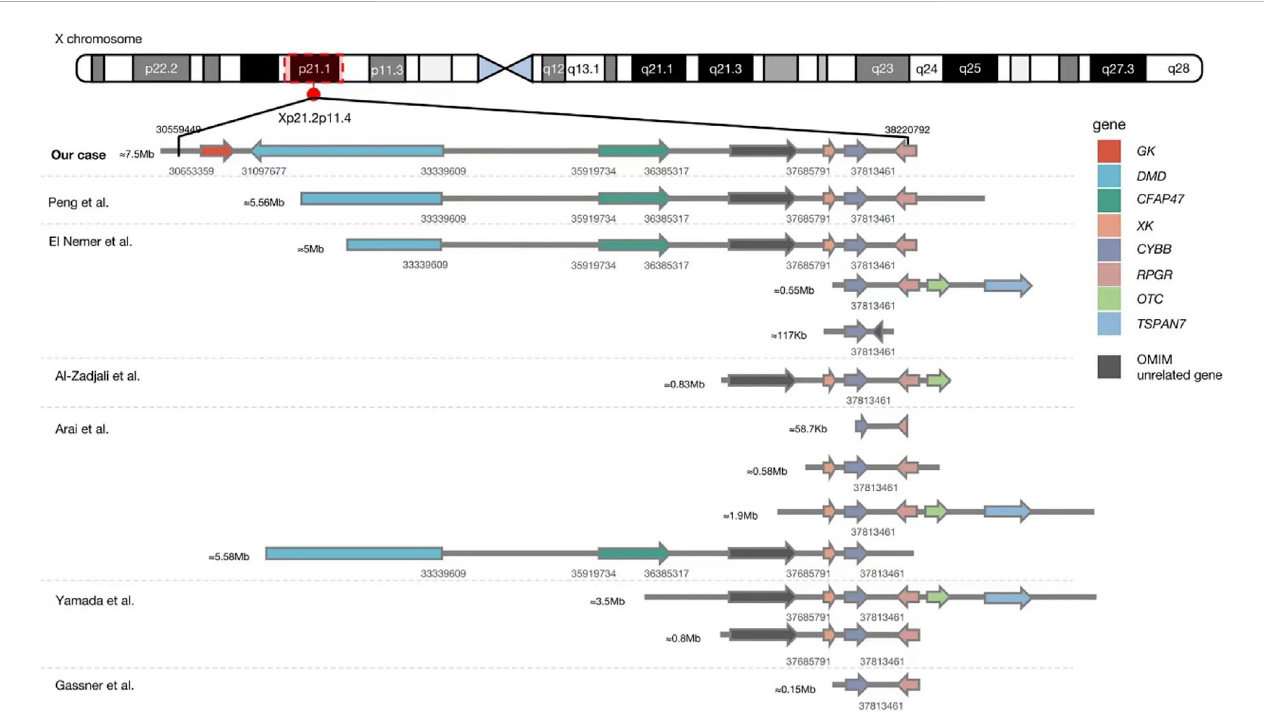
FIGURE 2 Comparison between ourcase and previously reported Xp21.1 contiguousgene deletionsyndrome with known deletionsites. The detailed genetic data of eight cases in one case series reported by Lhomme et al. (Lhomme et al., 2020) (8/8 with McLeod phenotype, 2/8 with DMD, and 1/4 with retinitis pigmentosa) are unavailable, so they cannot be aligned in this fi gure. Our patient had the most extensive gene deletion of ~7.5 Mb involving six genes with known phenotypes and a gene of unknown signi fi